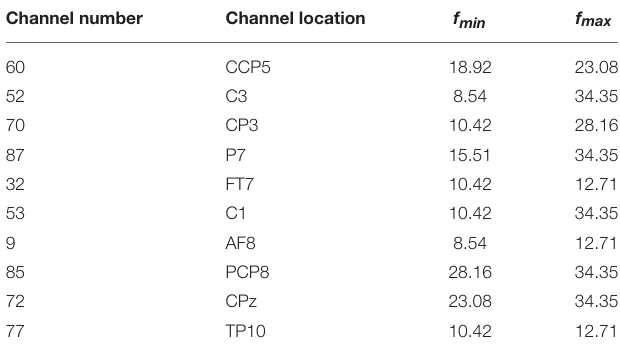
TABLE 1 | Statistics of the 2 datasets. Datasets